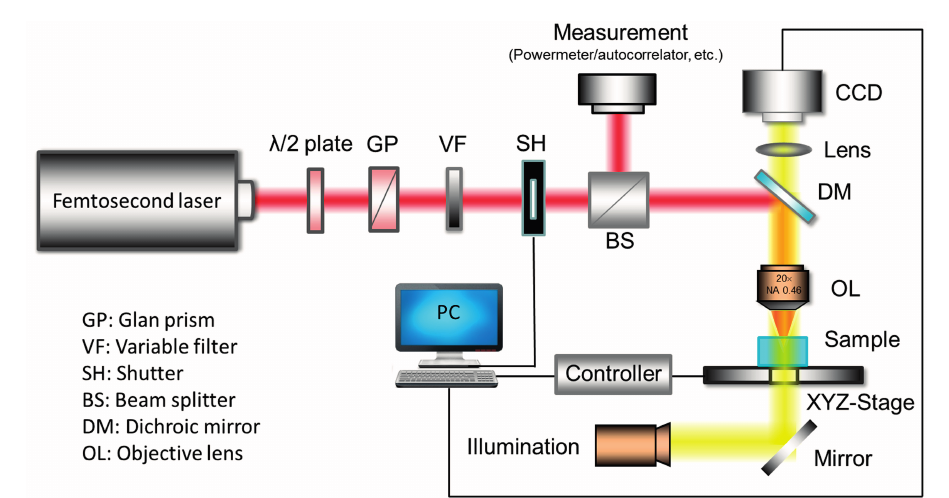
Figure 5. Schematic configuration of general femtosecond laser direct writing (FsLDW)